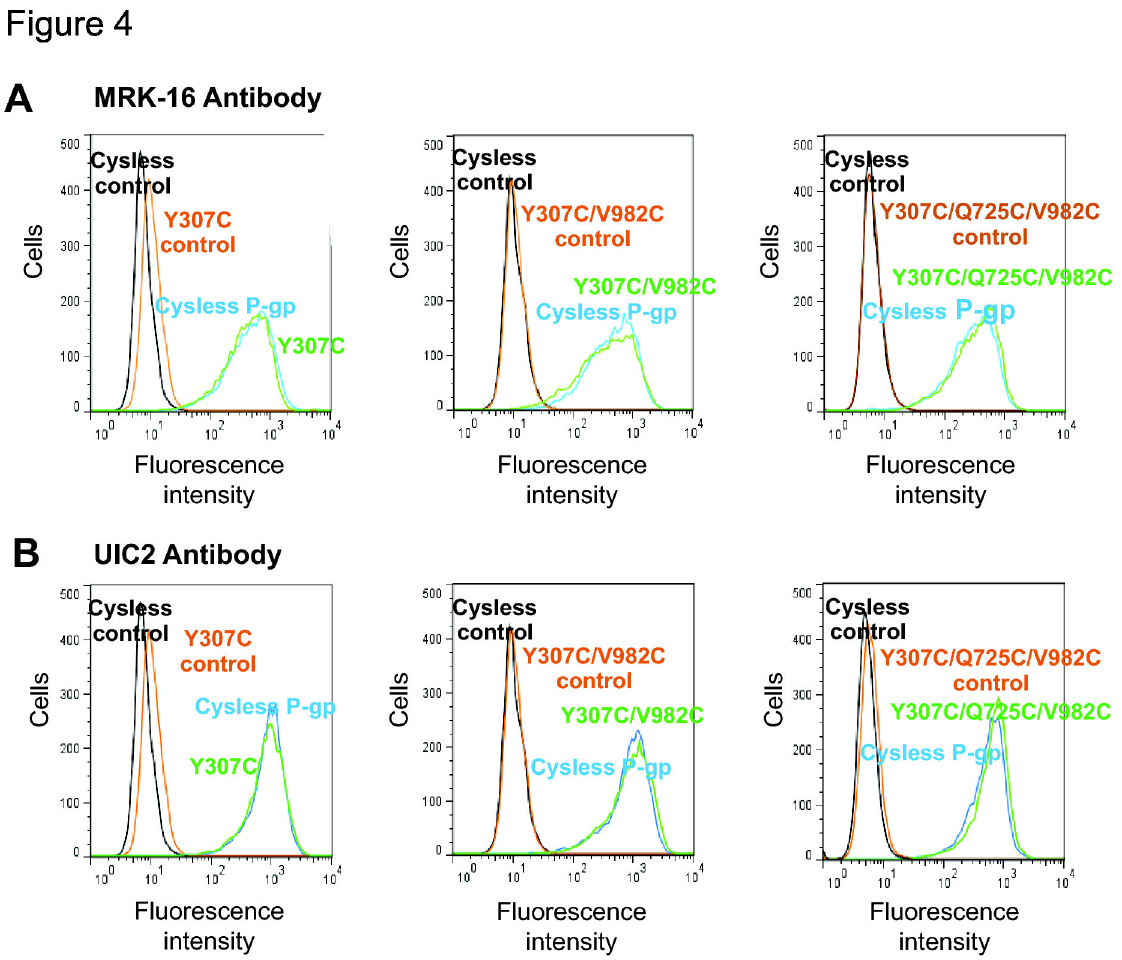
Figure 4. BacMam-baculovirus-transduced HeLa cells express normal levels of mutant Pgps at the cell surface. (A) The left panel shows the cell surface localization of Y307C with human Pgp-specific monoclonal antibody MRK-16 labeling as detected by green fluorescence detector. The middle panel shows the same for the double mutant Y307C/V982C, and the right panel for the triple mutant Y307C/Q725C/V982C. (B) The panels show the detection of the mutant Pgps with conformation-sensitive monoclonal UIC2 antibody after the treatment of cells with 20 µM CsA for 5 min at 37°C as described in Materials and Methods. The conformation sensitivity towards CsA of single (Y307C), double (Y307C/V982C) and triple (Y307C/Q725C/V982C) mutants was similar to cysless WT Pgp, as shown in the three panels, respectively. The histograms in both (A) and (B) are from one representative experiment, which was done independently at least three times. Samples treated with IgG2a isotype antibody are labeled as control. In all panels, the level of expression of cysless WT Pgp is shown for comparison and it is taken as 100% (see Table